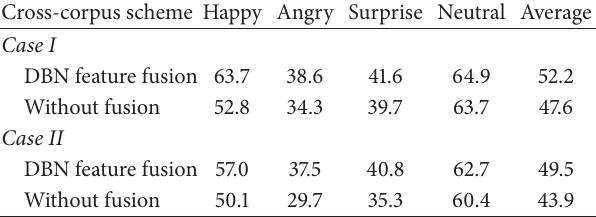
Table 1: Recognition results (%) of Fusion 1 in two cross-corpus cases.